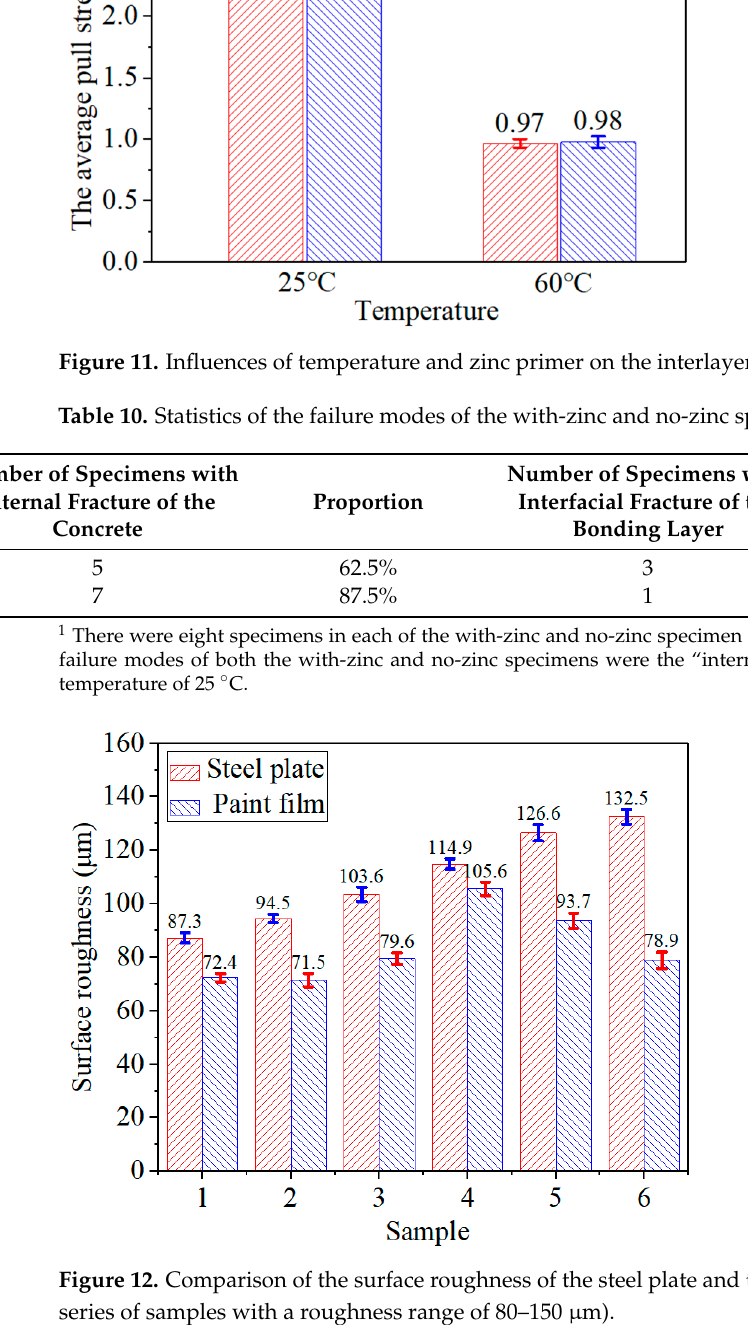
Figure 13. Comparison of the profiles of the steel plate surface without and with primer spray. 4.2. Analysis of the Bonding Interface 4.2.1. No-WBM Bonding Interface The bond strength of the no-WBM specimens (denoted as “no-WBM bond strength”) was measured using the PosiTest AT-A apparatus. The measurement data are shown in Table 11. The results of two-factor ANOVA of no-WBM bond strength are shown in Table 12. Significant probability of statistics (Sig.) for film thickness was 0.025 (<0.05), indicating that the thickness of epoxy zinc-rich paint film had a significant effect on the bond strength of no-WBM [40]. Table 11 shows the results obtained by repeating the pull test several times. The value of no-WBM sample 12 was significantly different, because the combina- tion of “A3 + B2” is prone to test errors without the waterproof adhesive layer. A two- factor ANOVA showed that the no-WBM bond strength decreased with the increase in the thickness of the zinc-rich epoxy primer (Figure 14). The no-WBM bond strength was the highest when the zinc-rich epoxy primer was 50–80 μ m thick. This result indicates that at a given steel plate roughness and within the range of the primer thickness in this study, a smaller zinc-rich epoxy primer thickness was more beneficial for the no-WBM bond strength.